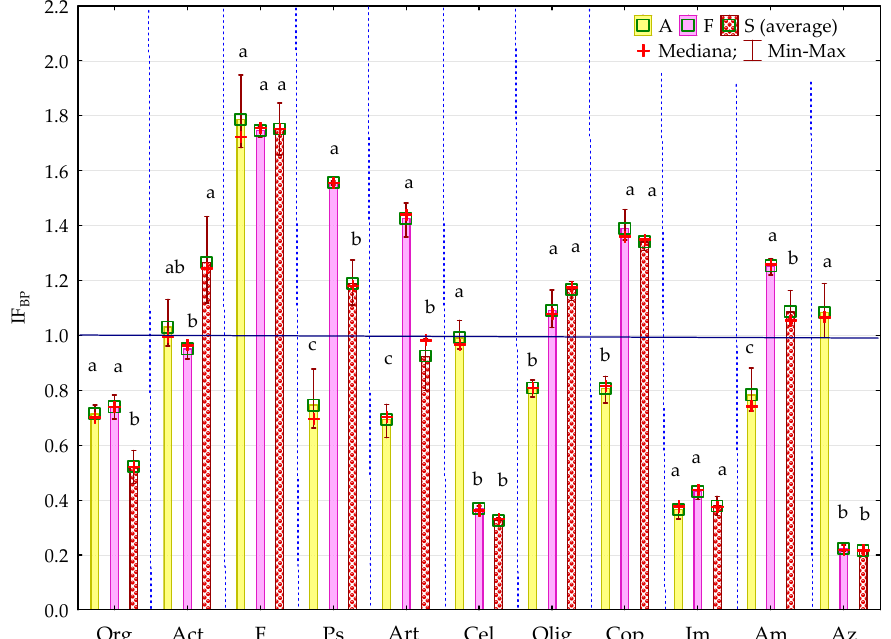
Figure 2. Coefficient of impact (IFBP) of bisphenols for group of microorganisms in soil contaminated with BPA, BPF and BPS on the 15th day of research, A—soil contaminated with BPA; F—soil contaminated with BPF; S—soil contaminated with BPS; Homogeneous groups denoted with letters (a–c) were calculated separately for each group of microorganisms (for abbreviations see Figure 1).